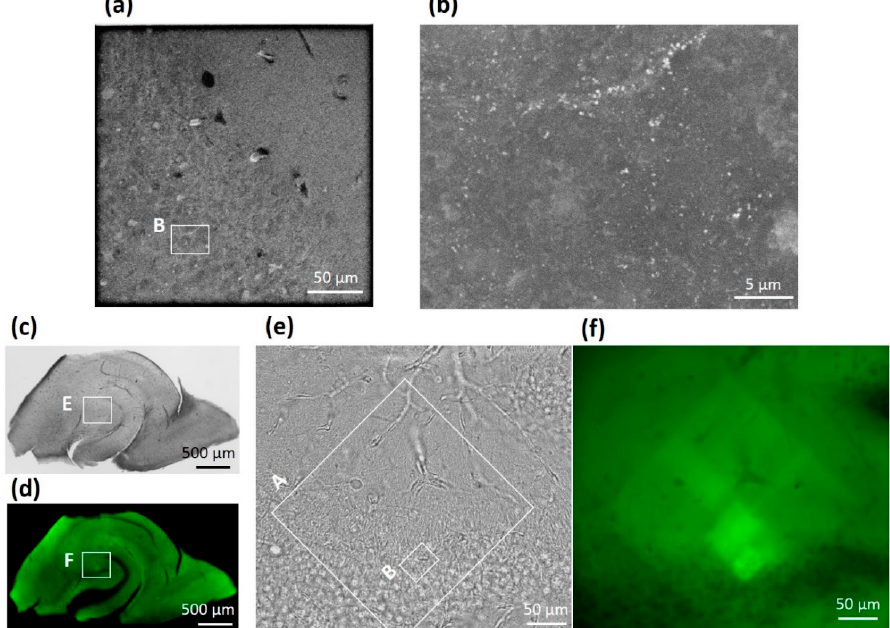
Figure 6. Mouse hippocampal tissue imaged using electron beam-induced EFP labeling and CLEM. The tissue was aldehyde-fixed, reduced, PCG/PTA stained, and EFP -labeled using the electron beam of an ASEM. ( a ) Low magnification SEM image of the tissue in a window; the outermost black border is the window frame. ( b ) Higher magnification SEM image of area B in ( a ). Precise structures of the hippocampus, including networks, were imaged by the inverted SEM. ( c ) Phase contrast microscopy and ( d ) FM of the tissue after the electron beam scanning. ( e ) Higher magnification phase contrast image of rectangle E indicated in ( c ). Areas A and B in ( e ) correspond to the scanned areas (SEM images) shown in ( a , b ). ( f ) Higher magnification FM image of the white rectangle F indicated in ( d ). The square area scanned at low magnification by the inverted SEM (i.e., the region shown in ( a )) was imaged brighter than the surroundings, and the rectangular area scanned at higher magnification (i.e., the region shown in ( b )) was imaged much brighter.